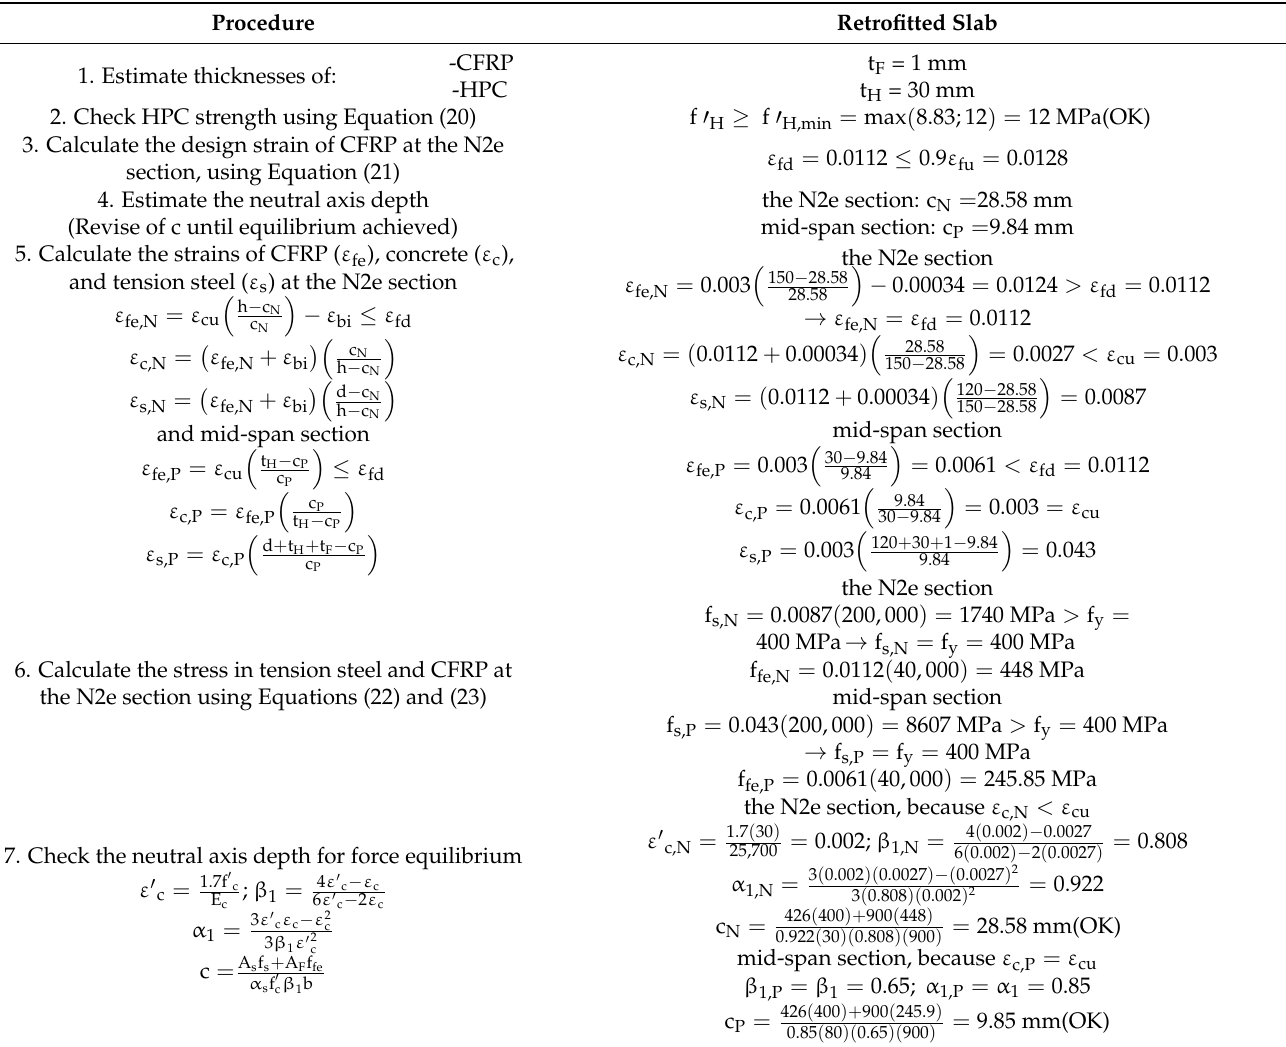
Table 5. The initial calculation for the retrofitted